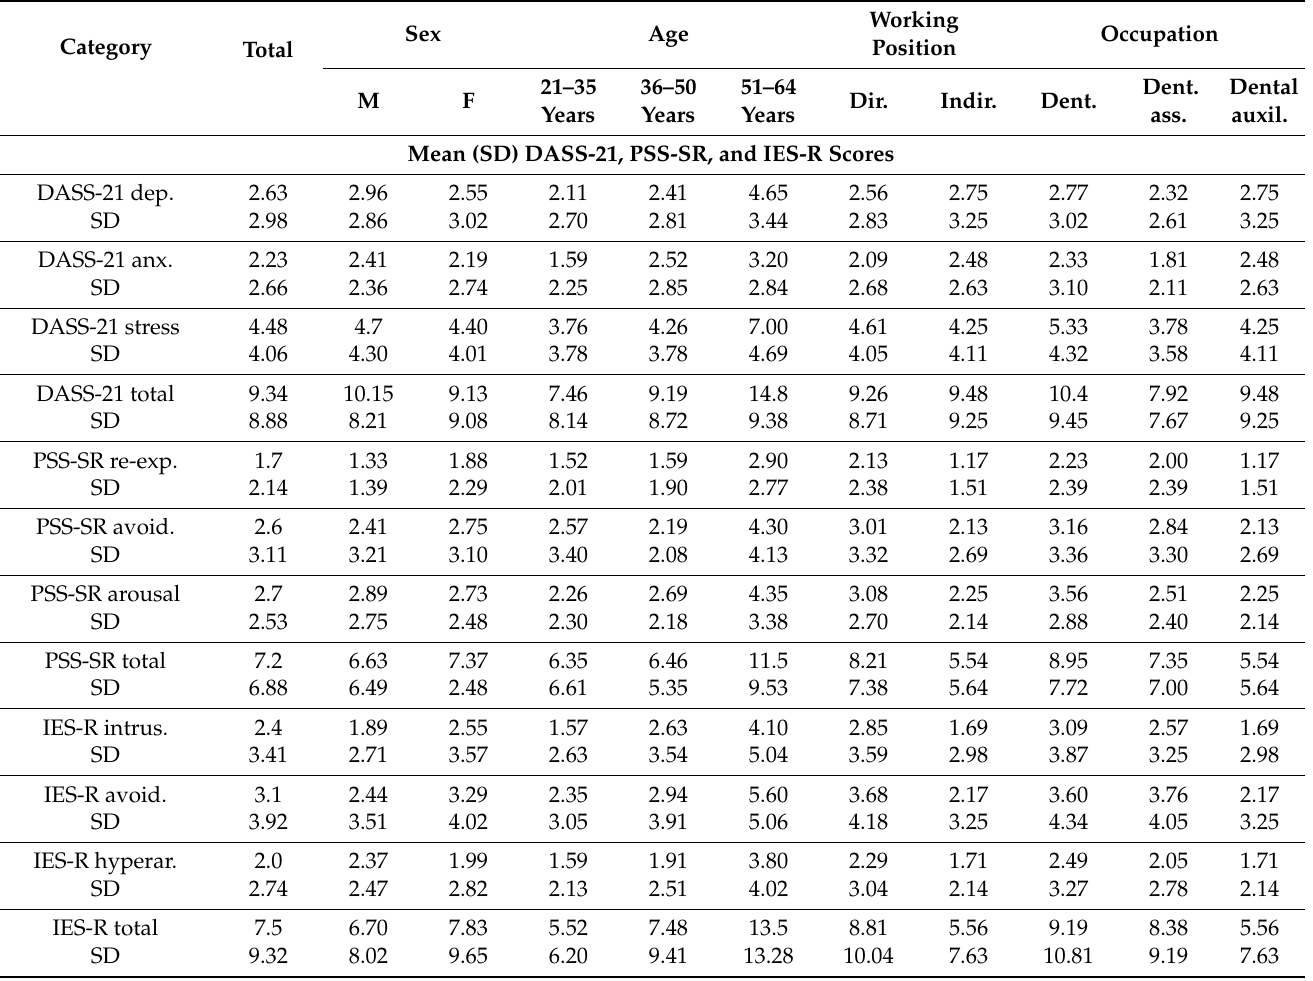
Table 3. Descriptive statistics for DASS-21, PSS-SR, and IES-R